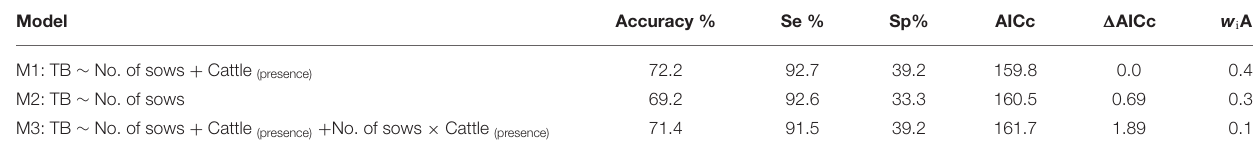
TABLE 2 | Logistic models with their accuracy, sensitivity, and specificity reported as percentage and their 95% confidence interval in parenthesis. Model